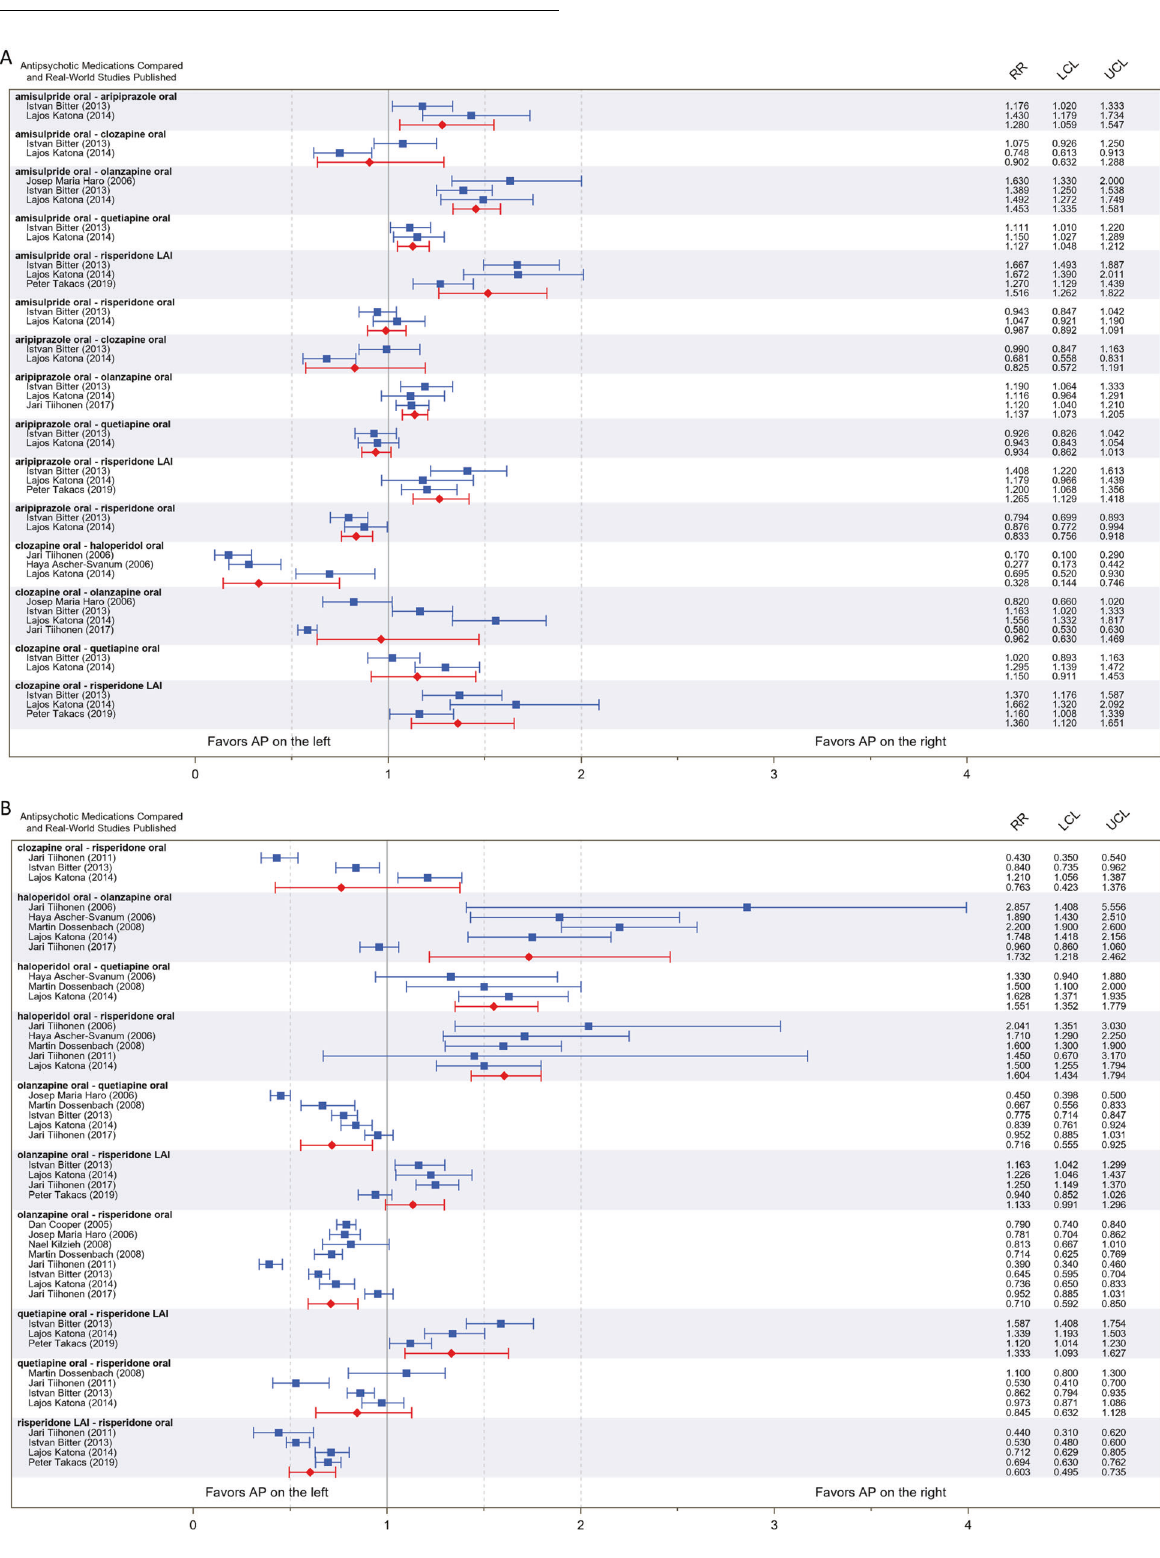
level estimates of all the relative risks within a group) from real- word studies were signi fi cantly less than 1; or greater than 1; or not differentiated from 1. There were 12 AP pairs (70.6%) where the input data can be considered homogenous: AMI-OLA, AMI-RIS LAI, ARI-OLA, ARI-RIS LAI, CLO-HAL, CLO-RIS LAI, HAL-QUE, HAL-RIS, OLA-QUE, OLA-RIS, QUE-RIS LAI, RIS LAI-RIS. We identi fi ed fi ve